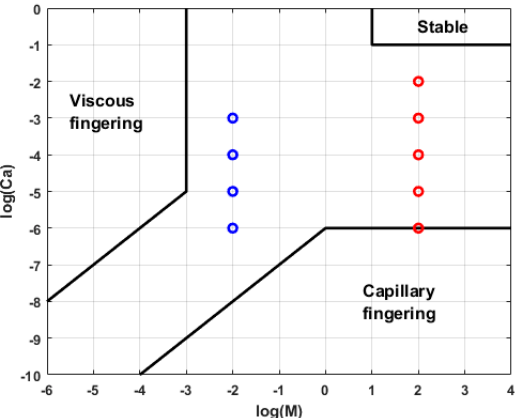
Figure 11. logCa–logM phase diagram. Blue points refer to the drainage experiment conditions and the red points to the imbibition experiment conditions.